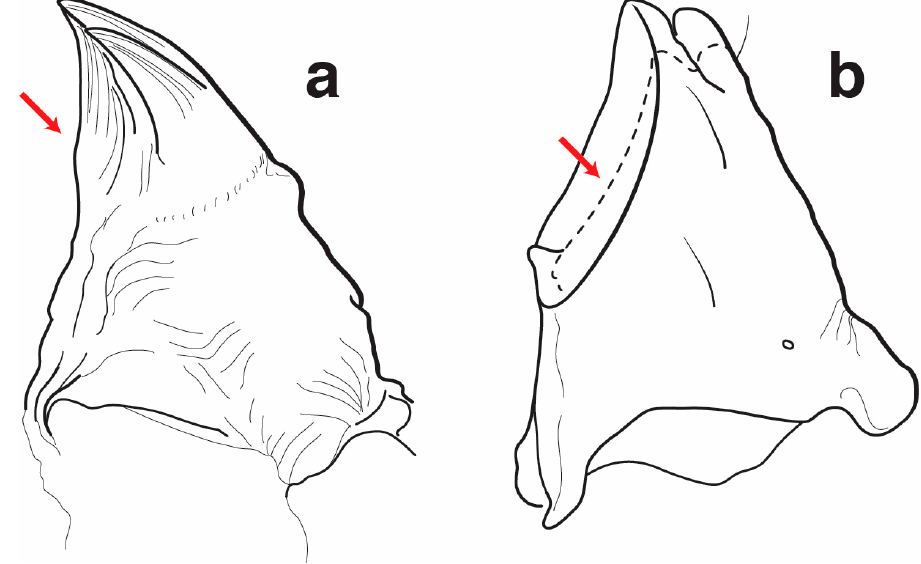
Figure 36. Mandible, larva: ( a ) Cyrtotrachelus ; and ( b ) Polytus .